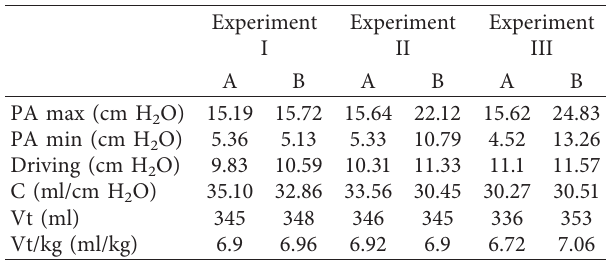
Table 3: Stage 1 in